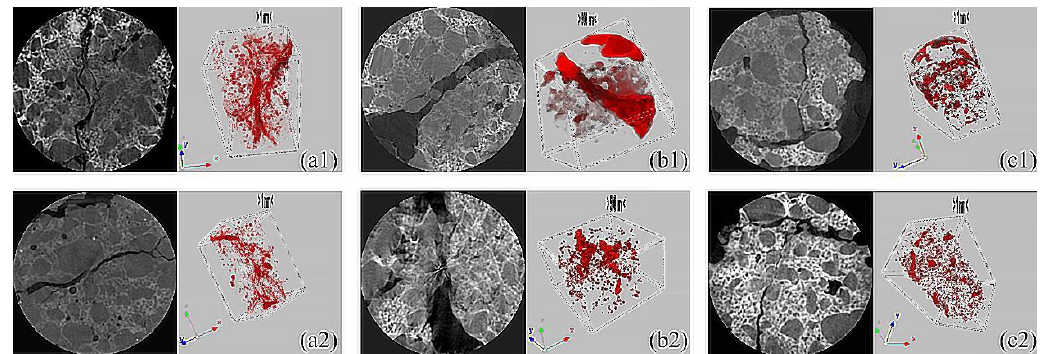
Figure 9. Initial microCT images depicting voids (in respect to both large pores and cracks) in red color for mortar-reference ( a 1 ), mortar-SAPs-1 ( b 1 ) and mortar-SAPs-2 ( c 1 ) and corresponding images after 8 days of healing treatment for mortar-reference ( a 2 ), mortar-SAPs-1 ( b 2 ) and mortar-SAPs-2 ( c 2 ).